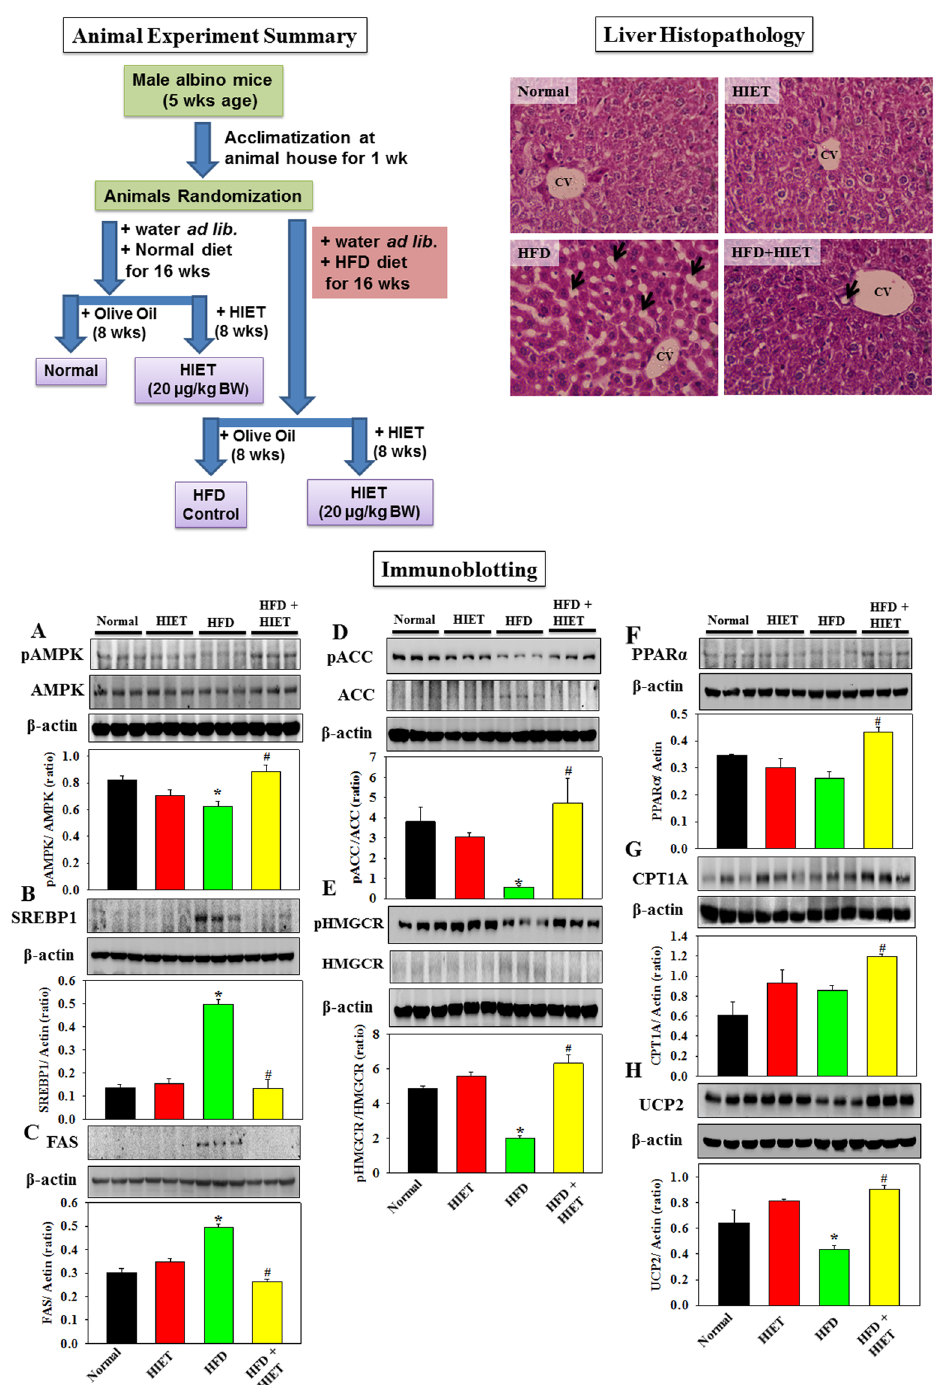
Figure 4. Schematic diagram of animal experiment and the effect of the hexane-isopropanolic extract of Tungrymbai, HIET on liver histology and the protein expressions of different signaling molecules in normal and high fat diet (HFD)-fed mice. Upper left panel represents the schematic diagram of animal experiment. Upper right panel represents the liver histology (40 × ) (arrows indicate lipid droplets). Lower panel represents the immunoblotting studies showing the protein expression of different signaling molecules including phospho AMPK/AMPK ( A ) SREBP1 ( B ) FAS ( C ) phospho ACC/ACC ( D ) phospho HMGCR/HMGCR ( E ) PPAR α ( F ) CPT1A ( G ) and UCP2 ( H ). The blots are representatives of three independent experiments. Full-length blots are presented in Supplementary Figure 4. Normal mice were gavaged with HIET at a dose of 20 µ g/kg BW (HIET) and HFD-mice were gavaged with HIET at a dose of 20 µ g/kg BW (HFD + HIET) daily for 8 wks, each group consisting of five mice. Data are expressed as mean ± SE. “ * ” Denotes the significant difference from Normal ( * p < 0.05) and “#” denotes the significant difference from HFD ( # p <